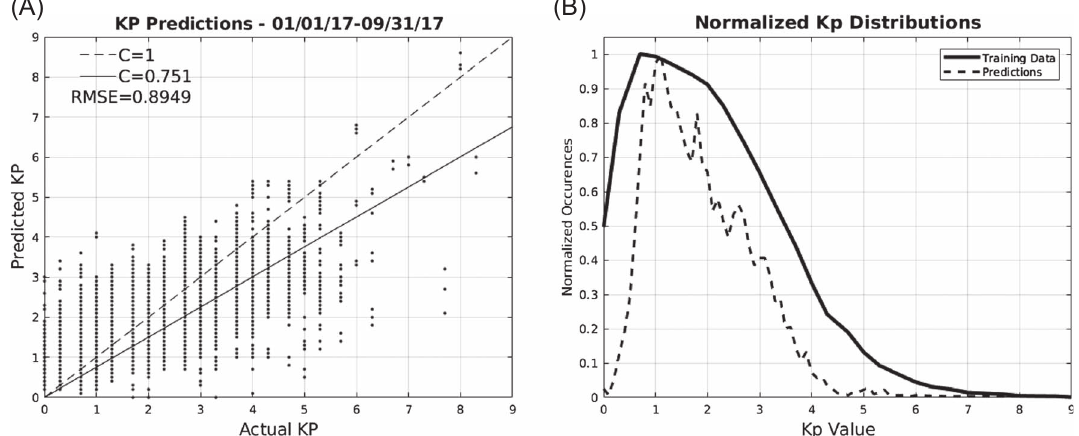
Fig. 3. (A) 6528 Kp predictions with s = 24, 01/01/2017 – 09/30/17 with inputs B z , n , r B . Each dot is a prediction plotted against its corresponding true Kp value, and the solid line indicates the line of best fi t with a slope of C = 0.751. Also shown is a line of slope 1, corresponding to an ideal correlation value. (B) Frequency of Kp values for full data set 1986 – 2016 and 2017 predictions. The imbalance of low Kp to high Kp in both sets is evident.